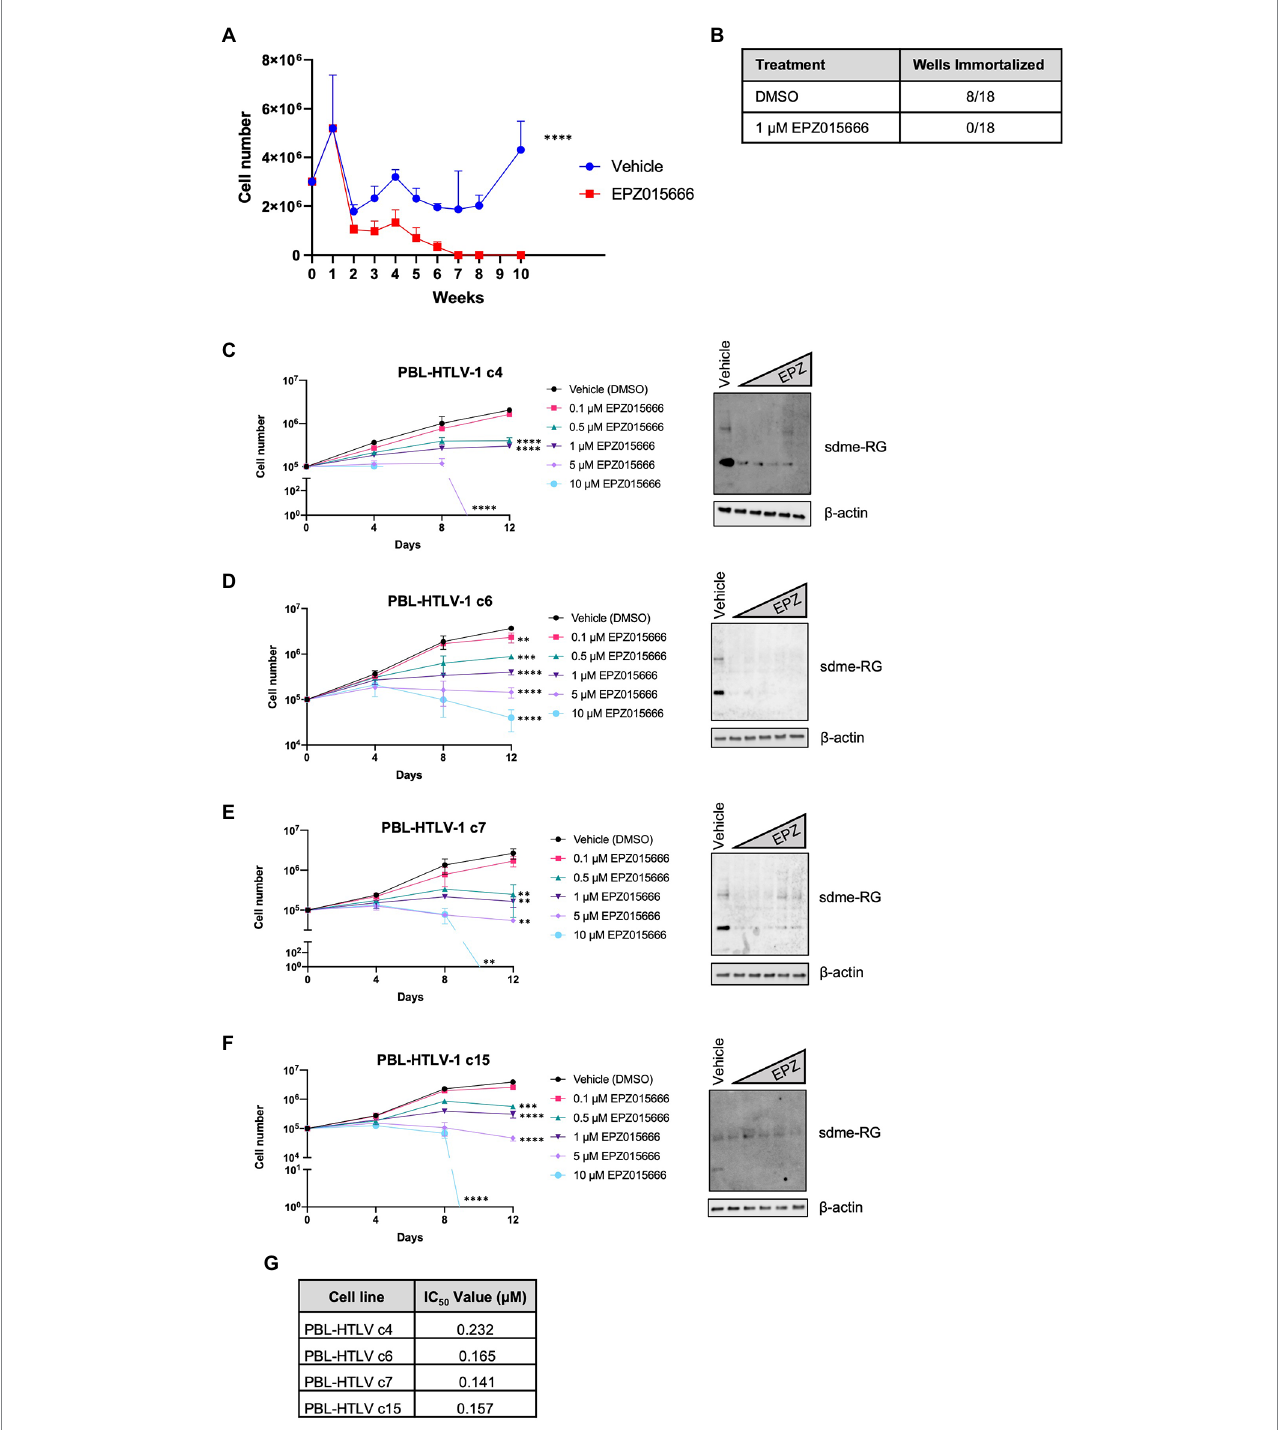
FIGURE 3 Loss of PRMT5 enzymatic activity blocks HTLV-1-mediated T-cell transformation. (A) Freshly isolated PBMCs (2 × 10 6 ) were co-cultivated with 10 6 lethally irradiated 729. ACH producer cells in 24-well plates. One week after co-culture, cells were treated with vehicle or 1 μ M EPZ015666 at weekly intervals. Viable cell number was assessed weekly via Trypan blue dye exclusion from three random independent wells. Ordinary two-way ANOVA with Sidak’s multiple comparison was used to determine significant differences between vehicle and EPZ015666-treated cells; p < 0.0001 (****). (B) Cells which outgrew the co-culture were considered immortalized after 15 weeks. (C–F) Newly infected and immortalized PBL cell lines (i.e., less than 9 months old) were treated with titrating doses of EPZ015666 (0.1–10 μ M) for 12 days (left panels). Viable cells were counted using Trypan blue dye exclusion. Each data point represents the mean for three replicates. Ordinary one-way ANOVA with Dunnett’s multiple comparison was used to determine significant differences between vehicle and EPZ015666-treated cells; p < 0.01 (**), p < 0.005 (***), p < 0.0001 (****). A portion of the cells were collected 4 days after EPZ015666 treatment and subjected to immunoblot analysis to compare the levels of Symmetric Di-Methyl Arginine Motif (sdme-RG) expression (right panels). β -actin was used as loading controls. (G) EPZ015666 IC 50 values were calculated for each cell